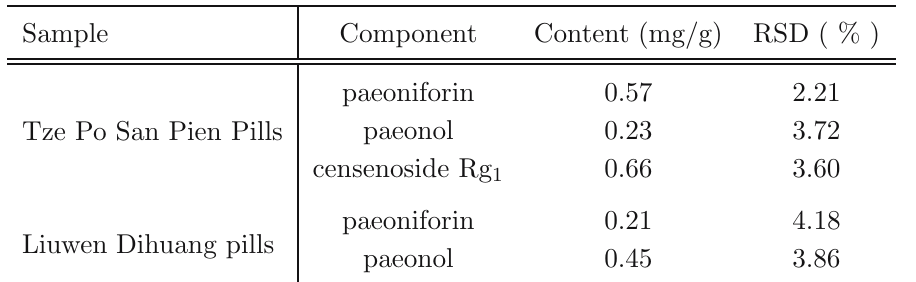
Table 1 Content of the analytes in Chinese medicinal preparations (n =